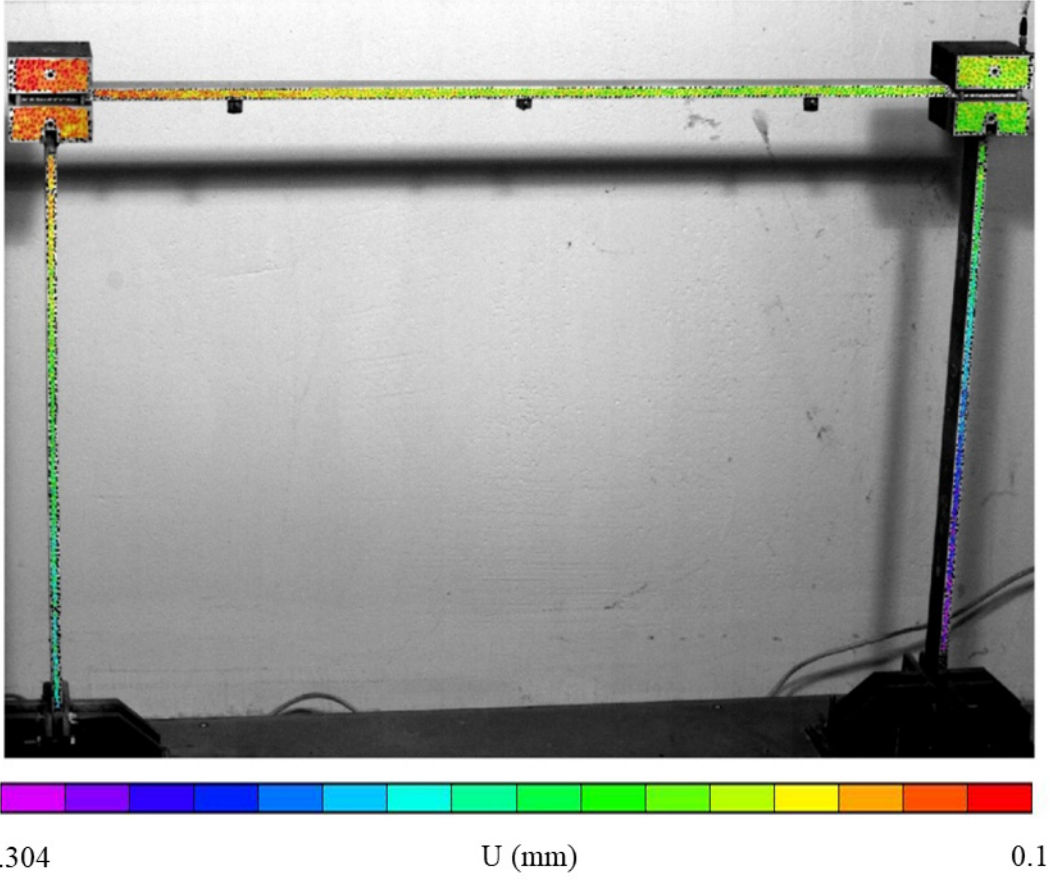
Figure 5. Horizontal displacement maps measured on the frame structure surface at a certain instant under broadband excitation.